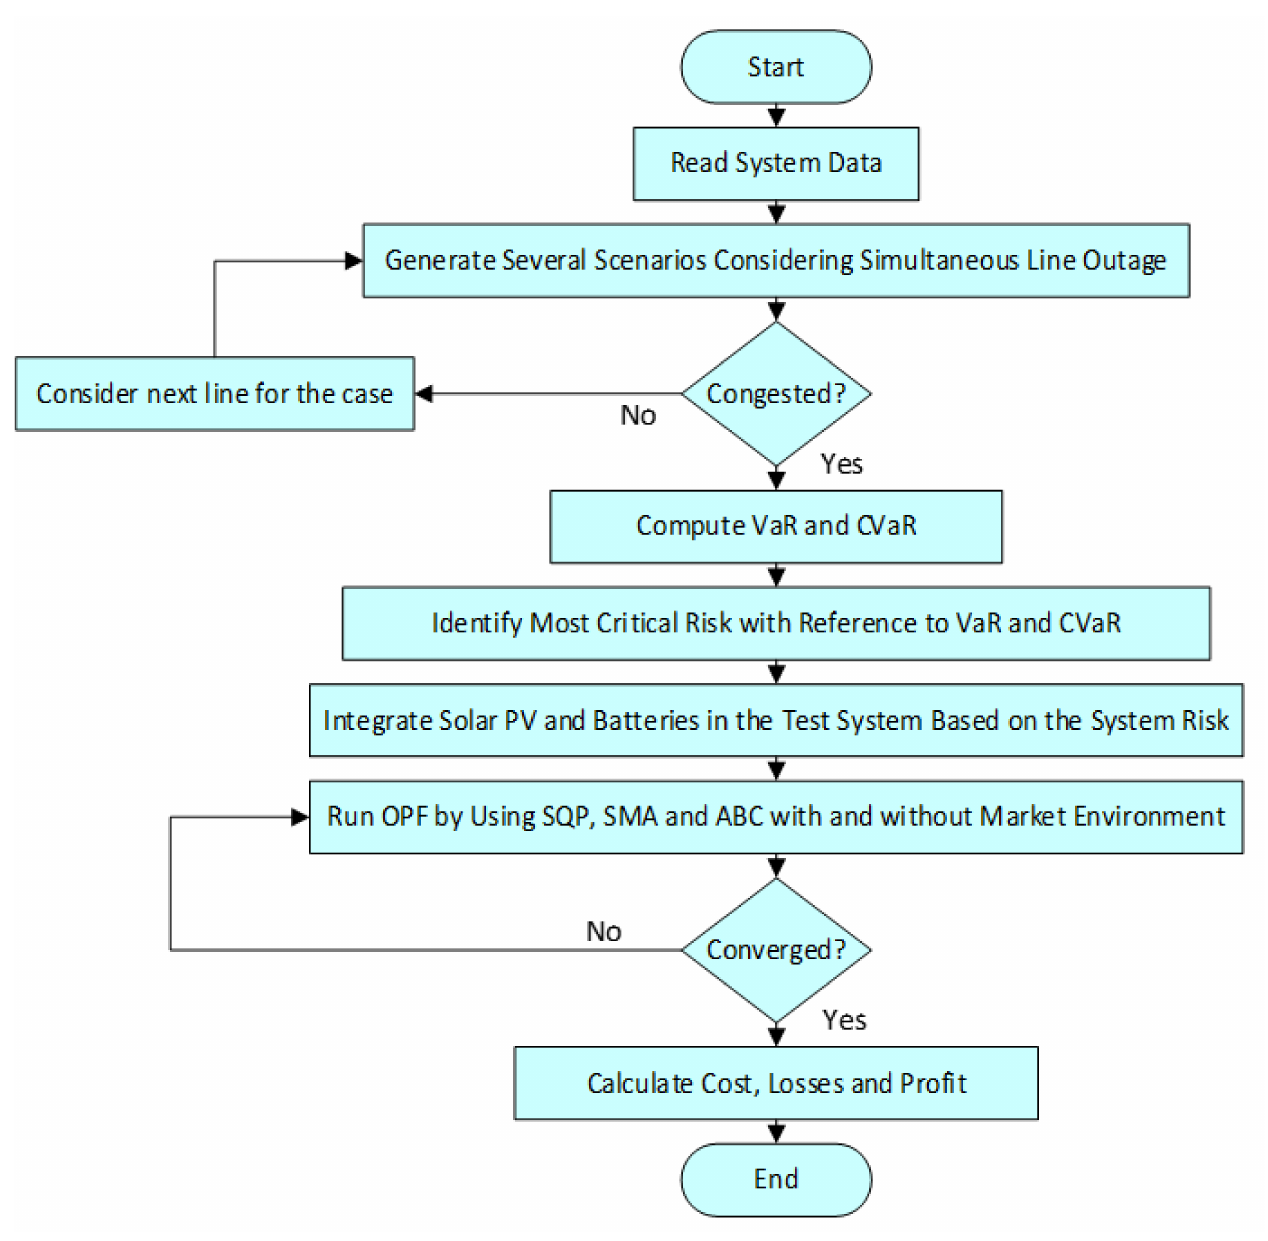
Figure 2. Analytic flow chart of the projected